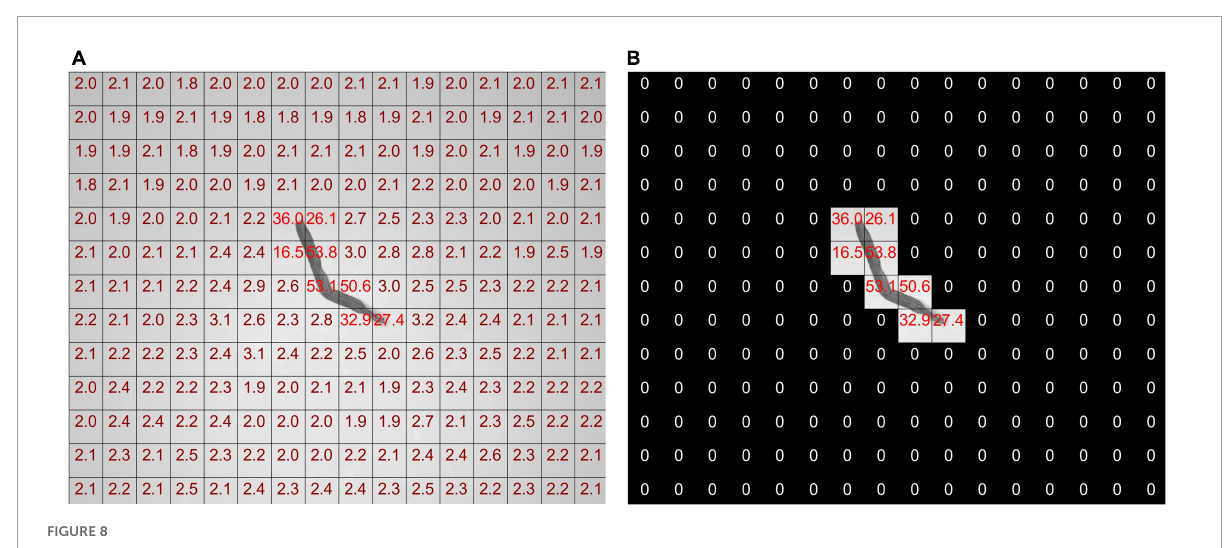
FIGURE8 Annotation map of the standard deviation of neighborhood blocks before and after processing (A) before, (B)